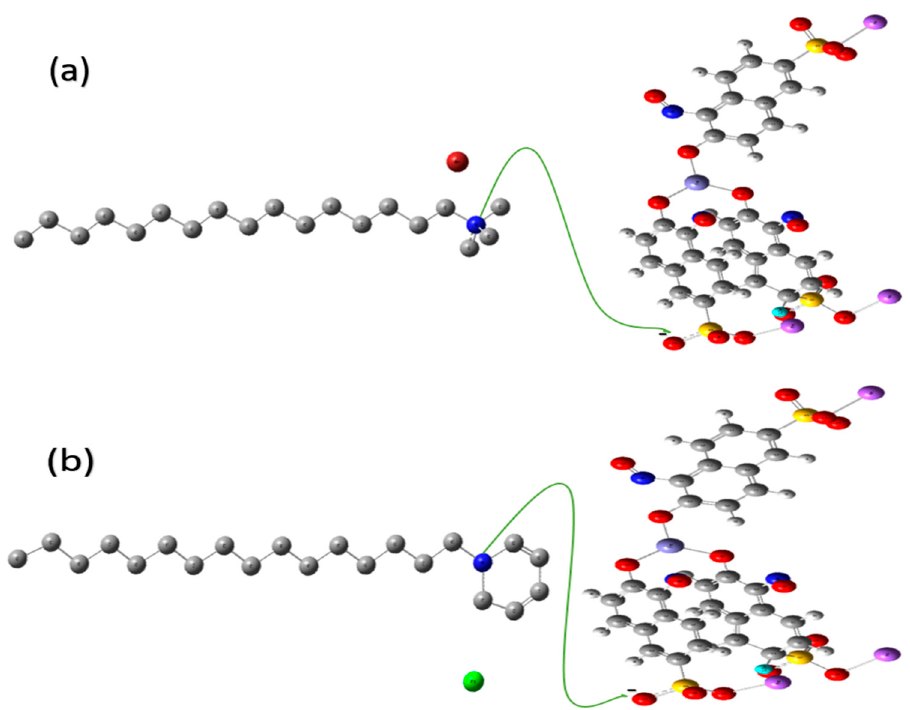
Figure 1. Spectra of simple absorption of NGB with and without surfactant.